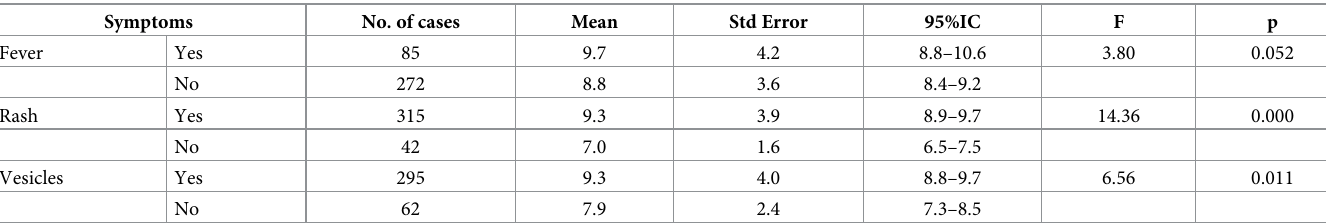
Table 2. Clinical symptoms of breakthrough varicella